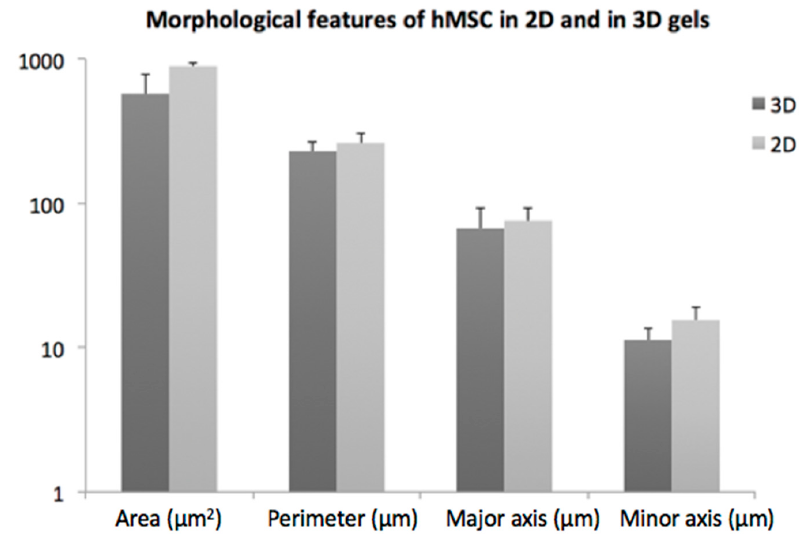
Figure 10. Histogram of Mesenchymal Stem Cells (MSCs) cultured either within 3D Self-Assembling Peptide (SAP) hydrogels or in 2D. No significant differences were observed by quantifying some morphological features of cells.